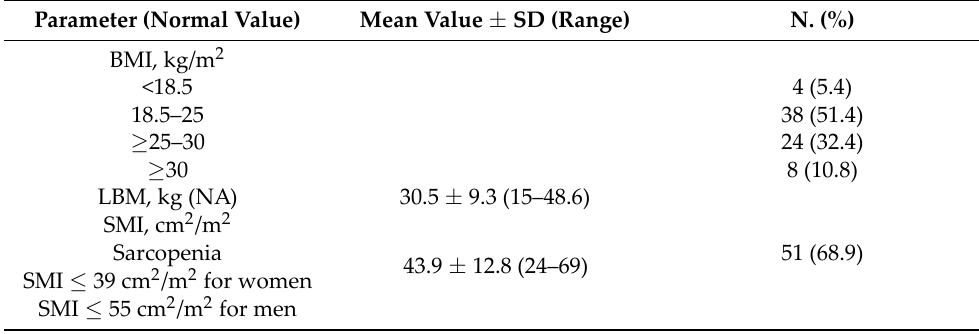
Table 2. Parameters of body composition and nutritional/inflammatory status at